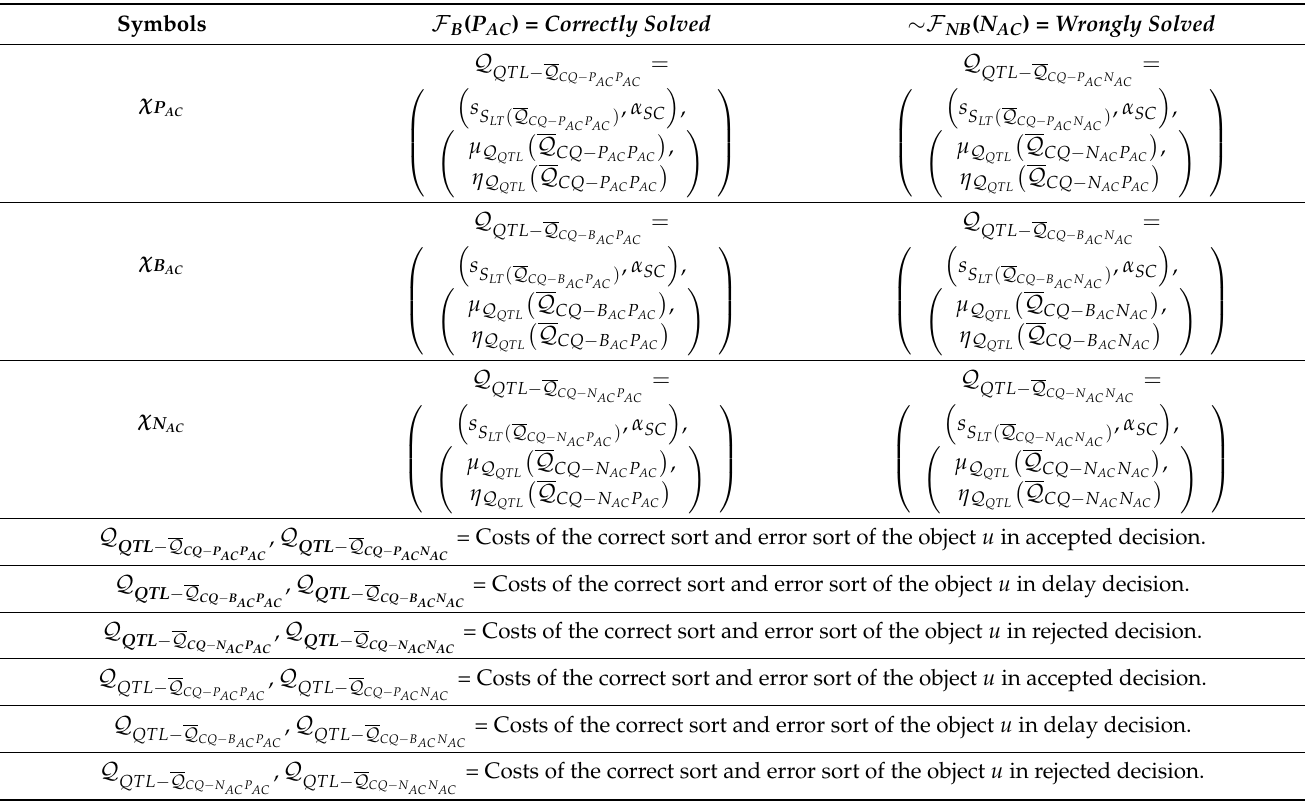
Table 2. Loss functions of